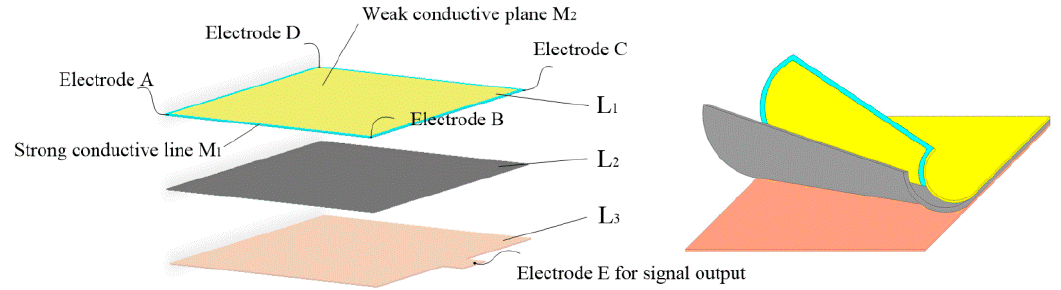
Figure 1. The structural model of the tactile sensor.